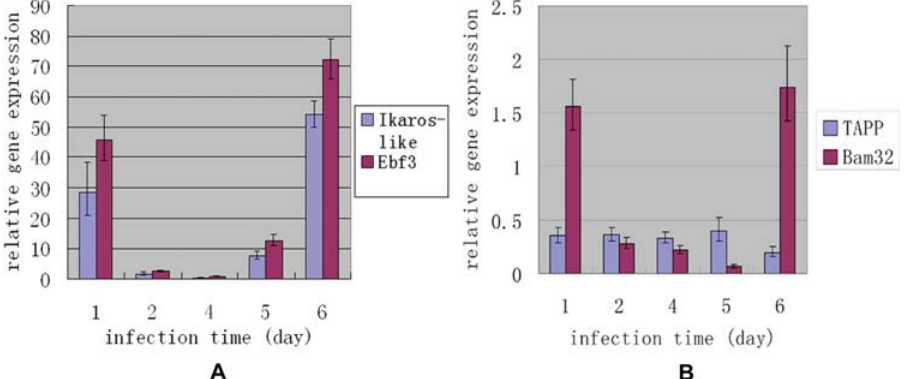
Figure 11. Analysis of gene temporal expression pattern by Real-time PCR analysis. Amphioxus mRNA extracted at 1 d, 2 d, 4 d, 5 d and 6 d after the V.p injections were used for Real-time PCR analysis. b -actin gene of amphioxus was used as endogenous control.